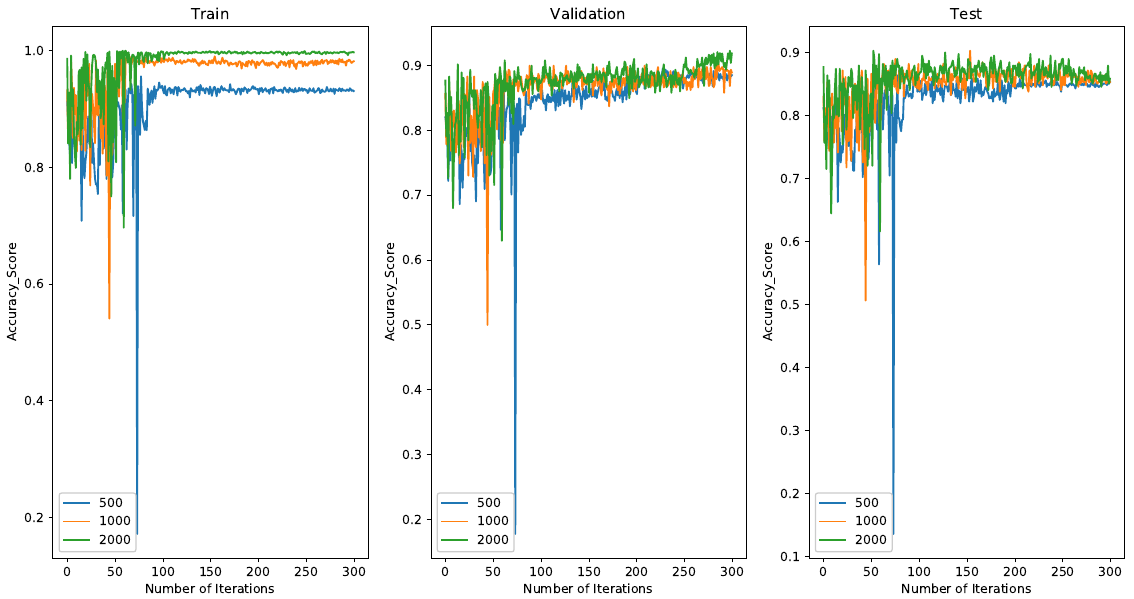
Figure 6. Convergence curve of the proposed algorithm for solving MINIST in training, validation and testing.